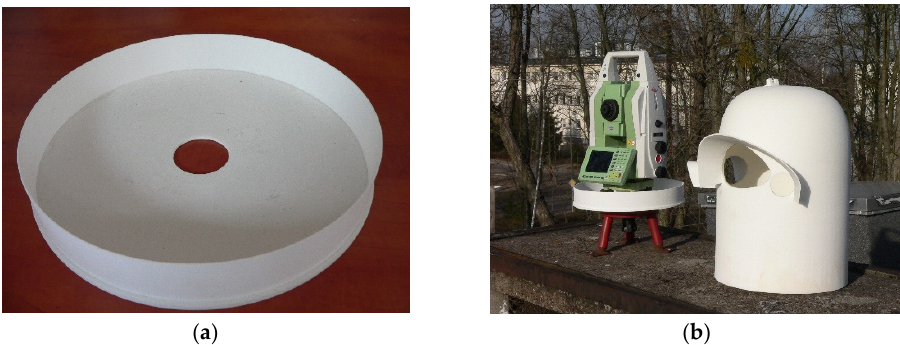
Figure 4. View of the profiled stand pad; ( a ) printed prototype, ( b ) implemented to the instrument standpoint (outdoor). standpoint